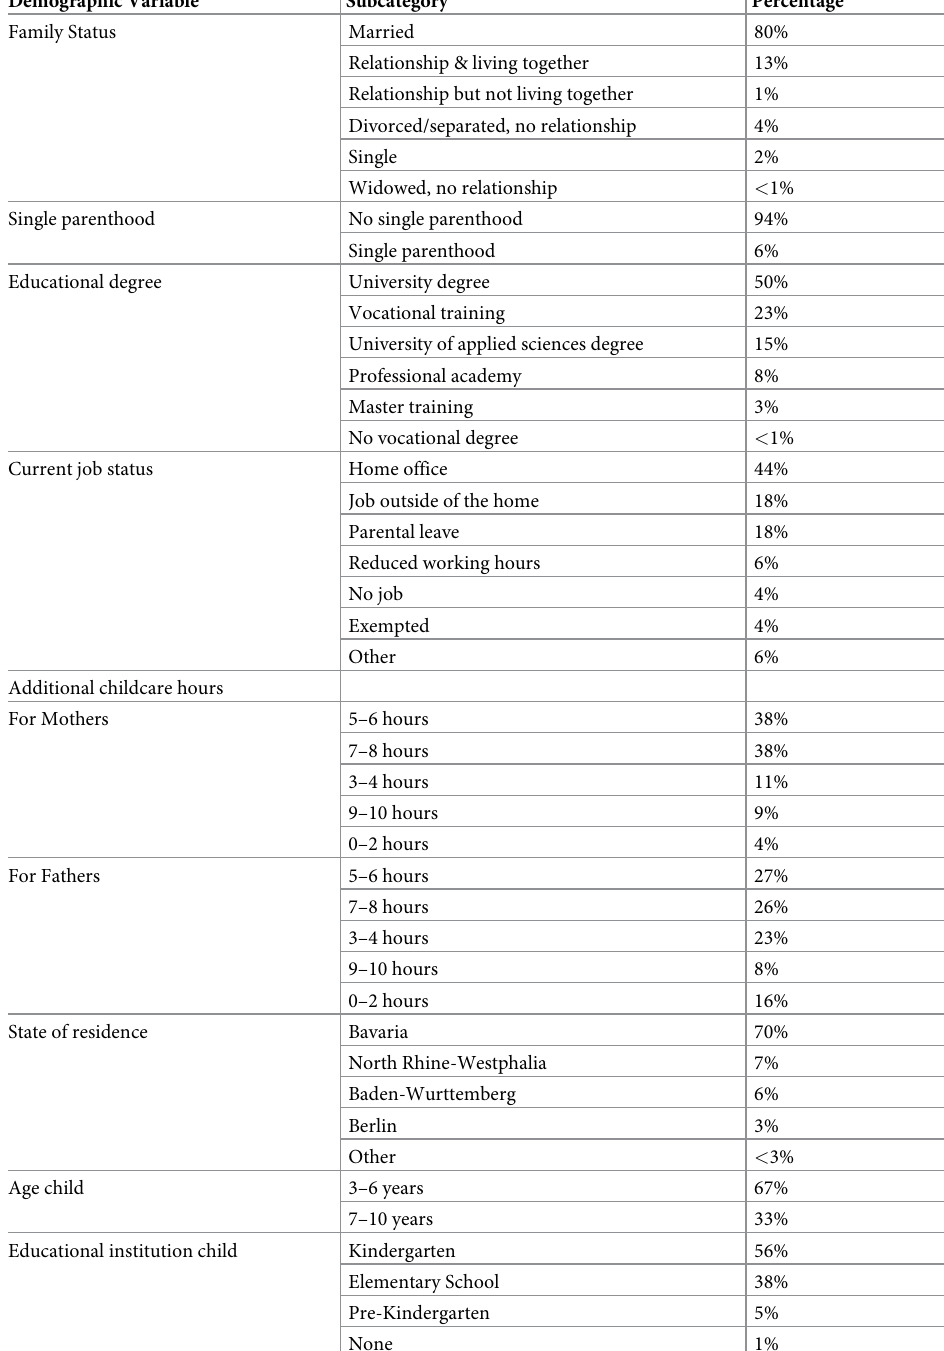
Table 1. Demographic characteristics of the